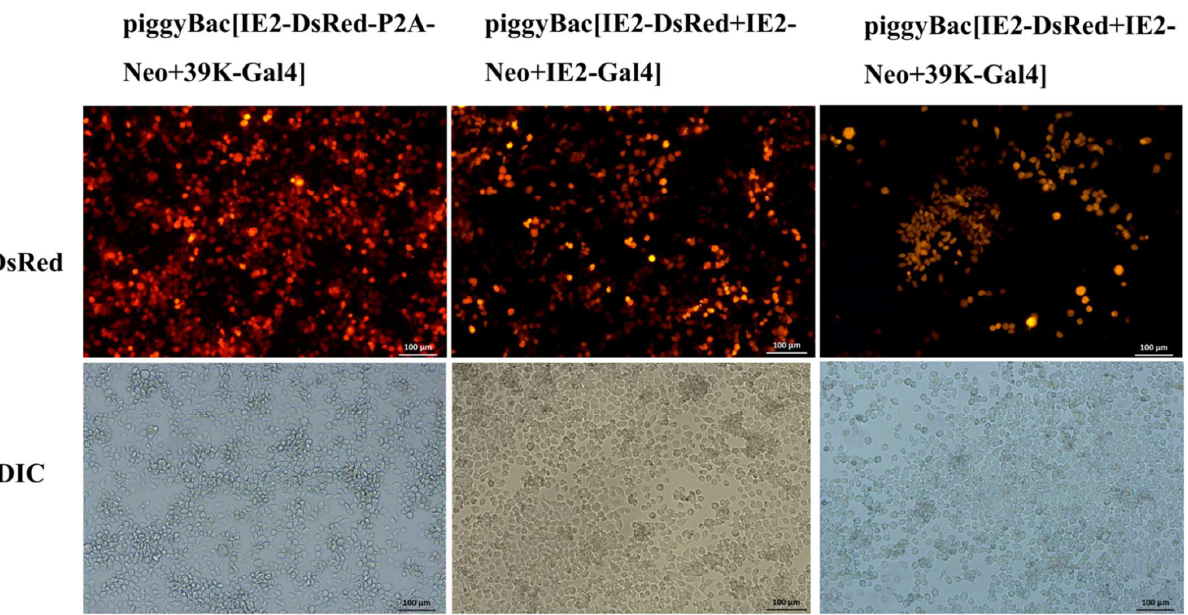
Figure 5. Observation of the transgenic BmE cells. For generating the transgenic BmN cells, the Gal4 expression vectors were mixed with the helper plasmid, respectively, and transfected into BmN cell by lipofection technique at 28 °C. The transgenic BmE cells were selected based on DsRed expression and G418 selection Panels: DsRed fluorescent field; DIC bright field. The scale bars in the visible images represent 100 μm.